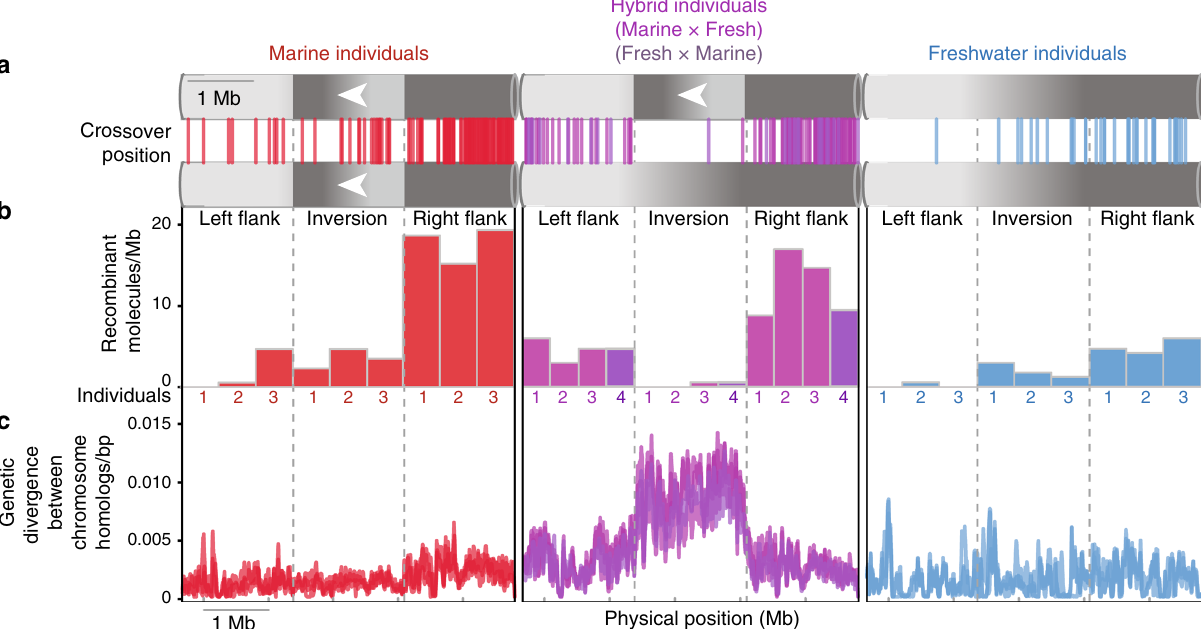
Fig. 4 ReMIX analysis reveals recombination suppression in individuals heterozygous for a chromosomal inversion. a , b A 1.7 Mb inversion on stickleback chromosome XXI differs in orientation between marine (red) and freshwater (blue) ecotypes. Meiotic crossovers, detected by ReMIX as recombinant molecules, occur throughout the inversion in individuals homozygous for either orientation (three marine and freshwater fi sh, respectively). In contrast, inversion heterokaryotypes (heterozygous for inversion orientation, hybrids, N = 4, purple) show recombination suppression within the inversion and elevated rates of recombination in the regions fl anking the inversion. c This recombination suppression allows the accumulation of linked genetic differences between the inverted haplotypes (shown for each individual as the number of heterozygous sites/bp in 20 kb windows)